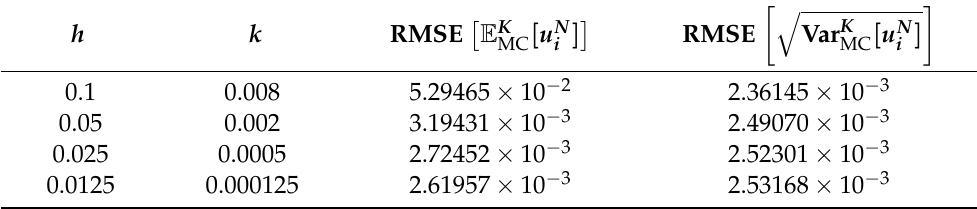
Table 3. CPU time (in seconds) spent to compute the approximations to the expectation (mean), E K and the standard deviation, h = 0.0125 and k = 0.0001 while the number of MC simulations, K , varies.